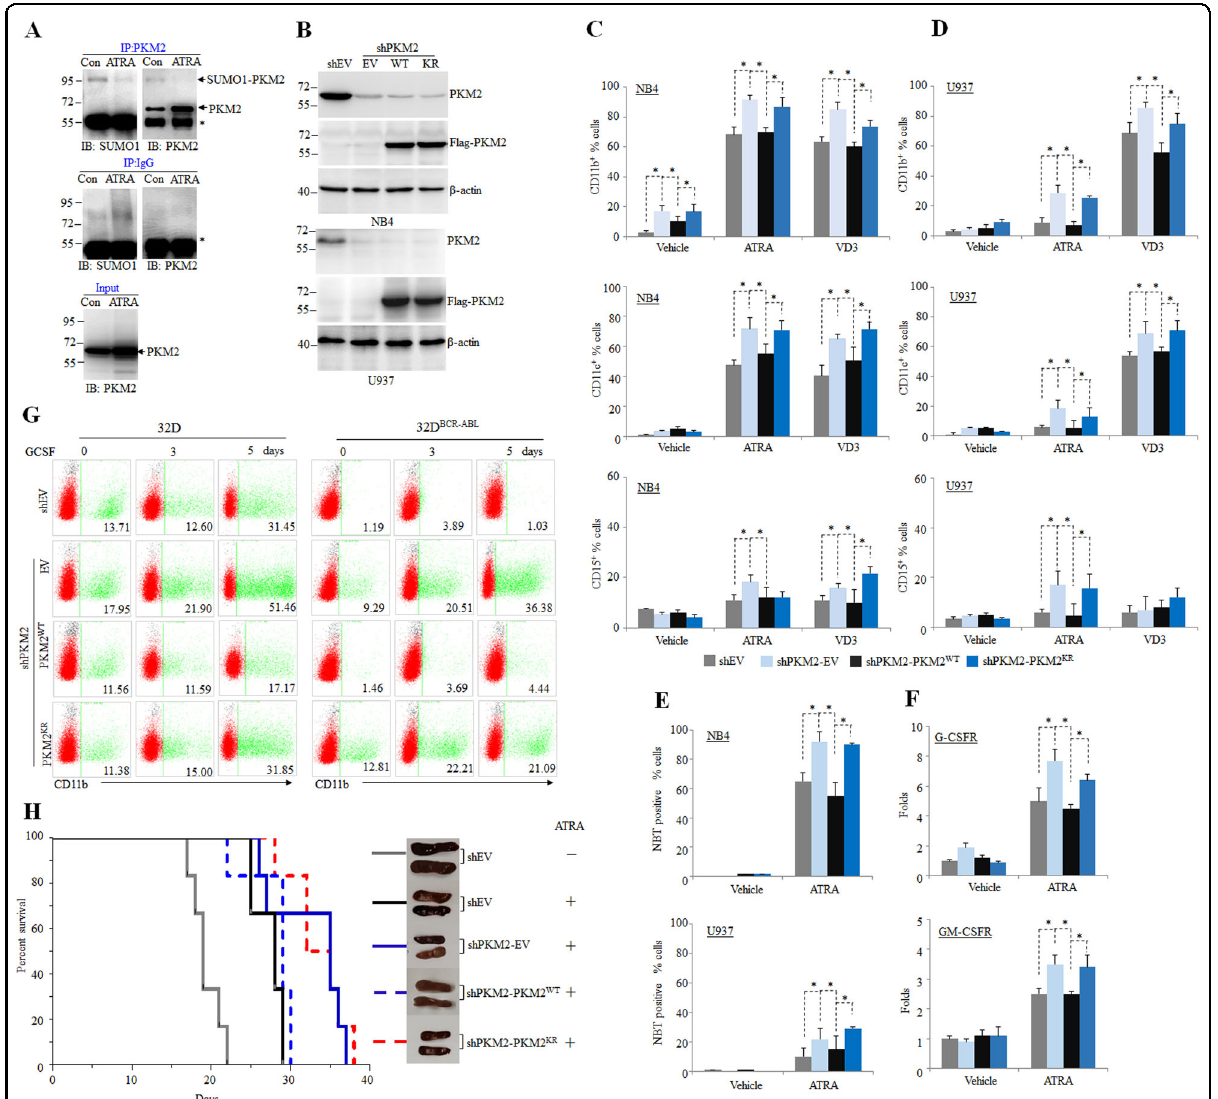
Fig. 4 SUMOylation of PKM2 inhibits myeloid differentiation. A NB4 cells were treated with 10 − 8 M ATRA for 3 days followed by IP with anti- PKM2 antibody. The SUMO1 modi fi cation were analyzed by western blot using anti-PKM2 antibody. B Western blot analysis of NB4 and U937 cells in which endogenous PKM2 was stably knocked out and WT PKM2 (WT) or K270R mutant (KR) were re-expressed. C – E The NB4 and U937 rescue cell lines were treated with 10 − 8 M ATRA or 100 nM VD3 for 3 days and the CD11b-positive, CD11c-positive, or CD15-positive cells were measured by fl ow cytometry ( C , D ) and NBT positive cells were counted ( E ). * p < 0.05 between the line-pointed group. F The mRNA level of GCSFR or GMCSFR quanti fi ed by real-time RT-PCR were shown. G The 32D or 32D BCR-ABL rescue cell lines were treated with 50 ng/ml GCSF for indicated times and the CD11b-positive cells were counted by fl ow cytometry. Data are shown as the mean ± SEM of three independent experiments. H Human NB4 cells (1 × 10 7 ) were injected via tail vein into sub-lethally irradiated NSG mice followed by treatment with vehicle or ATRA (10 mg per kg body weight, intraperitoneally) daily for fi ve continuous days a week. The survival data were collected. The representative pictures of spleens from each group were shown on the